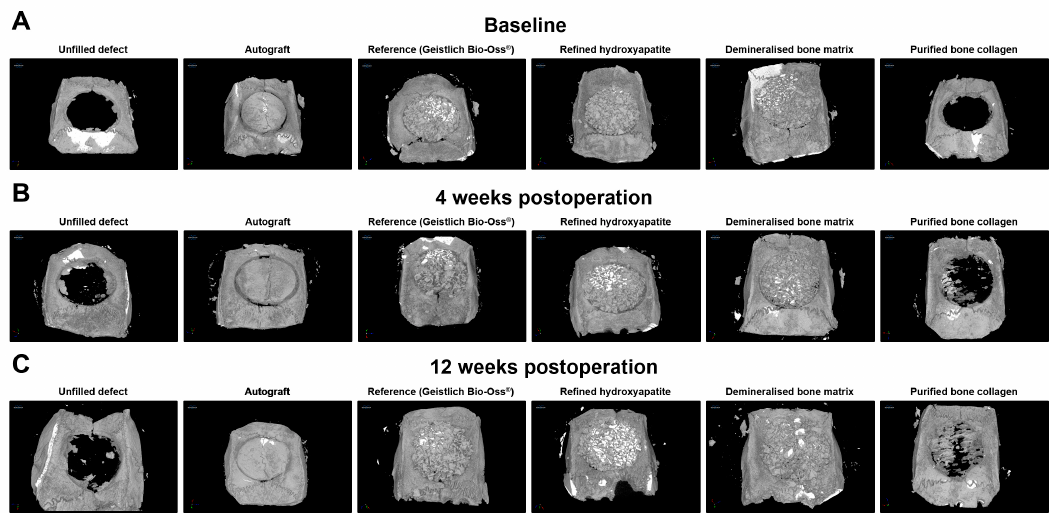
Figure 1. Representative microcomputed tomography images demonstrating filling of the critical- sized (8 mm diameter) rat calvarial defect upon the implantation of bovine-derived HA, DBM, and COLL at the baseline ( A ) and in a ( B ) short- and ( C ) long-term. Unfilled defect, autograft, and